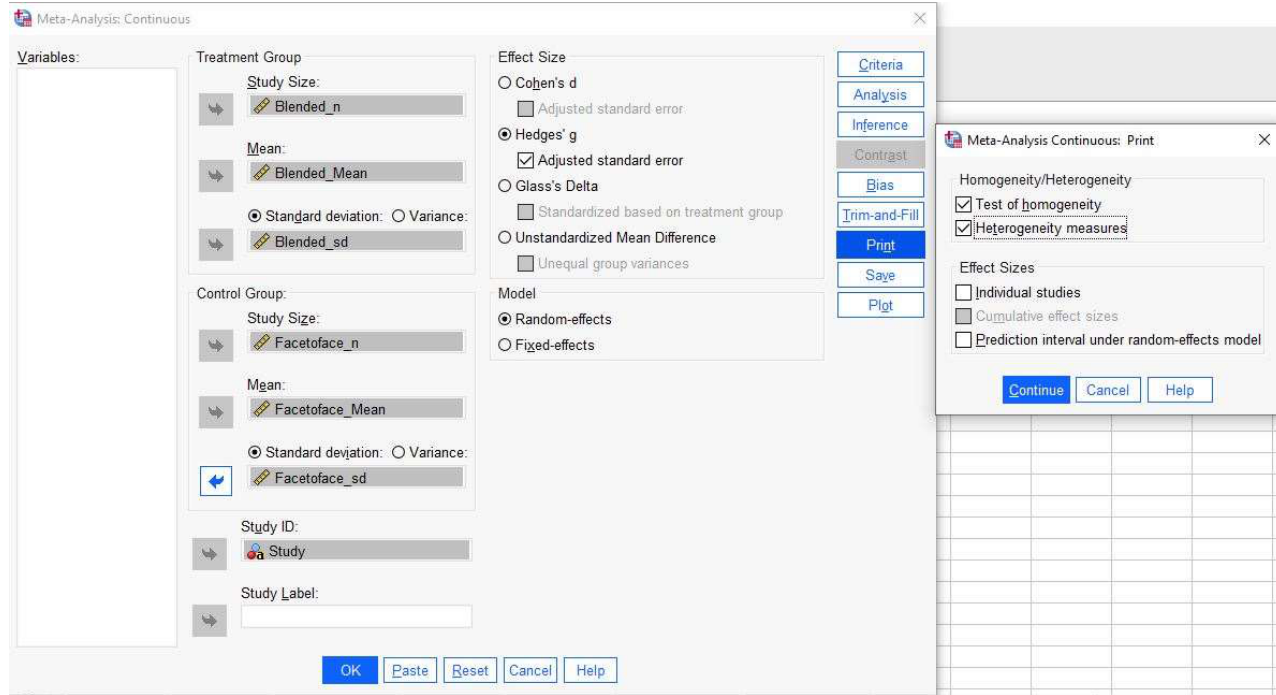
Figure 5. Data Identification Menu.